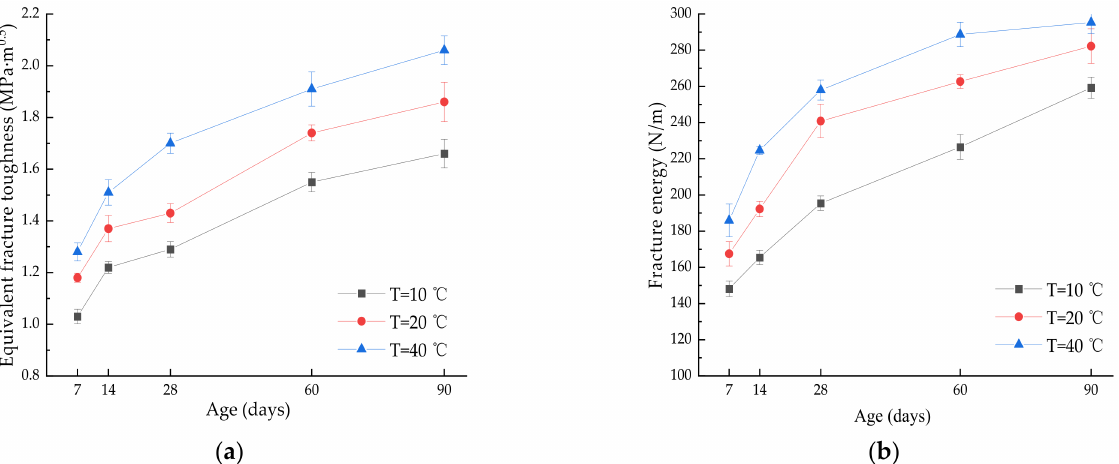
Figure 11. Fracture parameters of gallery concrete under different curing temperatures: ( a ) equivalent fracture toughness; ( b ) fracture